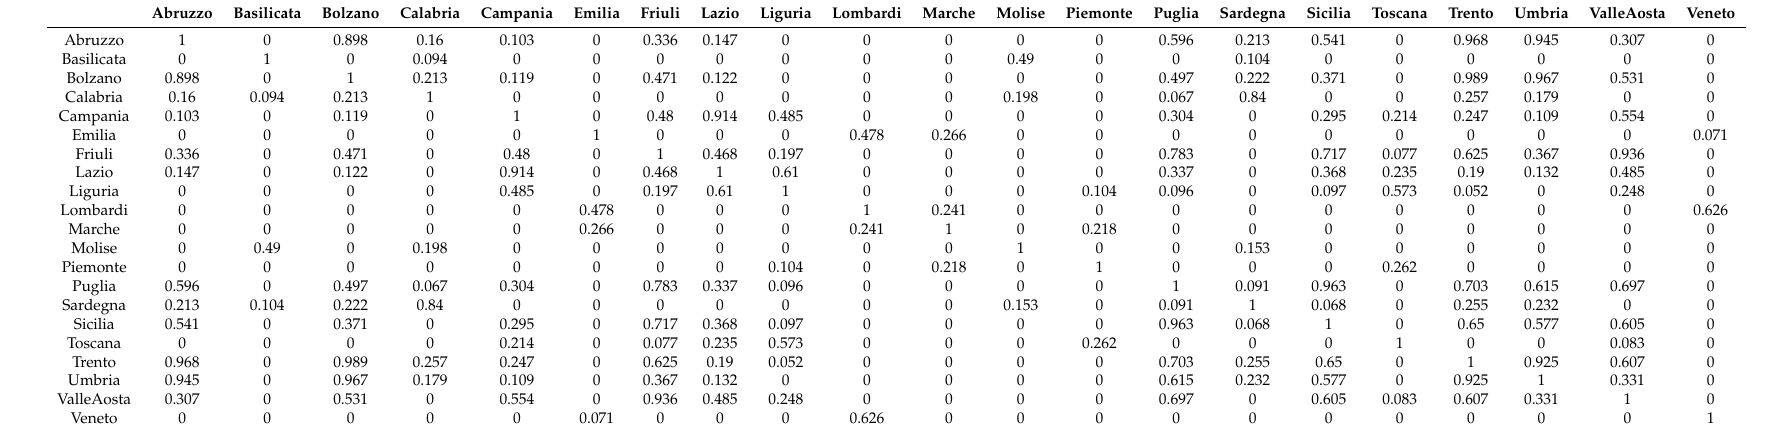
Table A25. Similarity values of Total Currently Positive network in the study period.